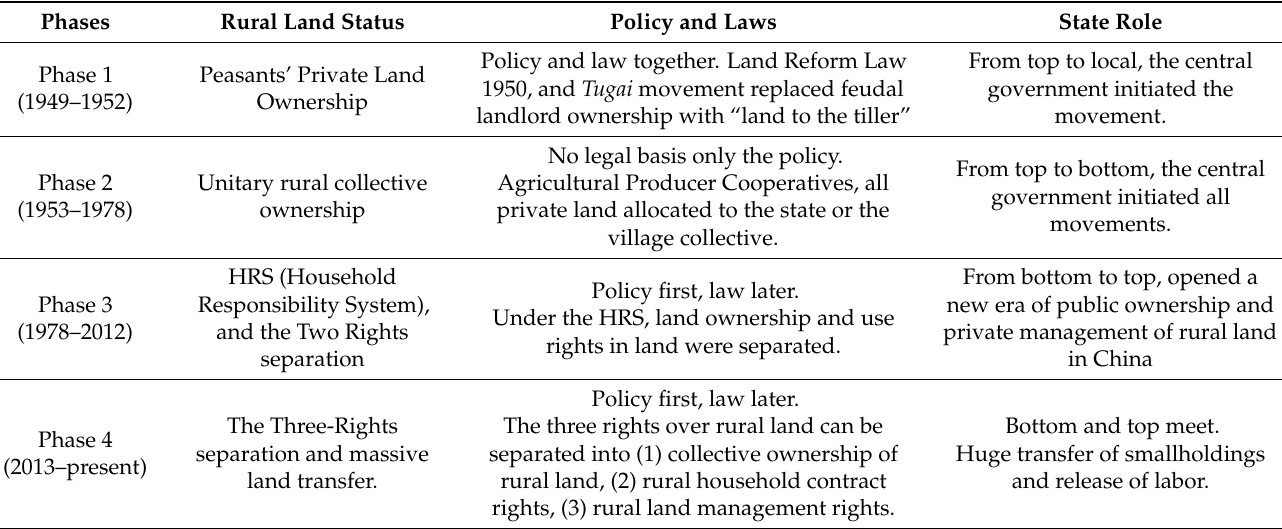
Table 1. The Evolution of Rural Land Tenure in China since